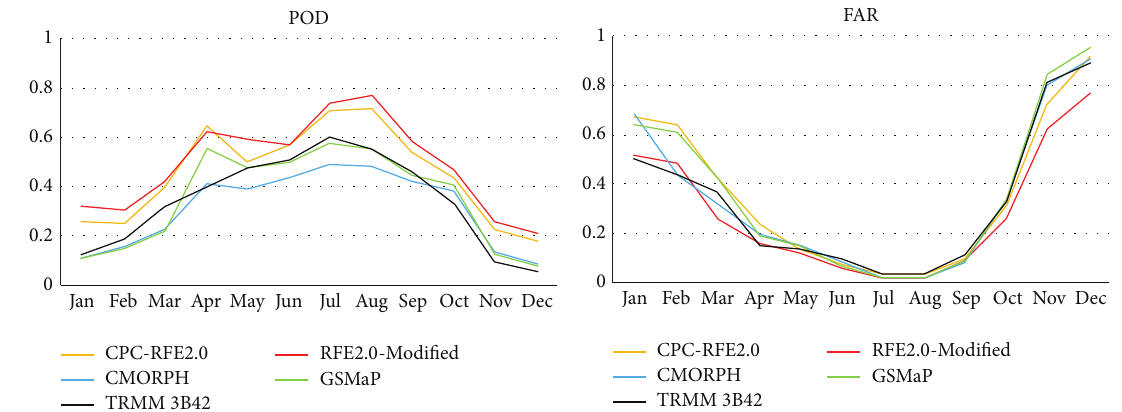
Figure 6: Month average of daily error categorical statistics of satellite rainfall for 2004 to 2006 (G-G analysis).